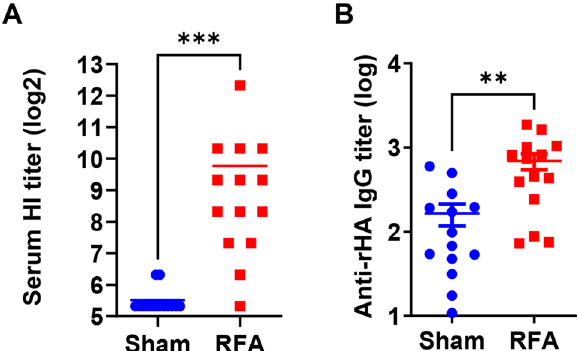
Figure 6. RFA enhances pdm09 vaccine-induced antibody responses. BALB/c mice were subjected to RF or sham treatment followed by ID delivery of 0.3 µg pdm09 vaccine into RF or sham-treated skin. Immunization was repeated 3 weeks later. Serum HI titer ( A ) and anti-rHA IgG titer ( B ) were measured 3 weeks after boost. Two-tailed student’s t-test was used to compare differences between groups. n = 14. **p < 0.01; ***p < 0.001.